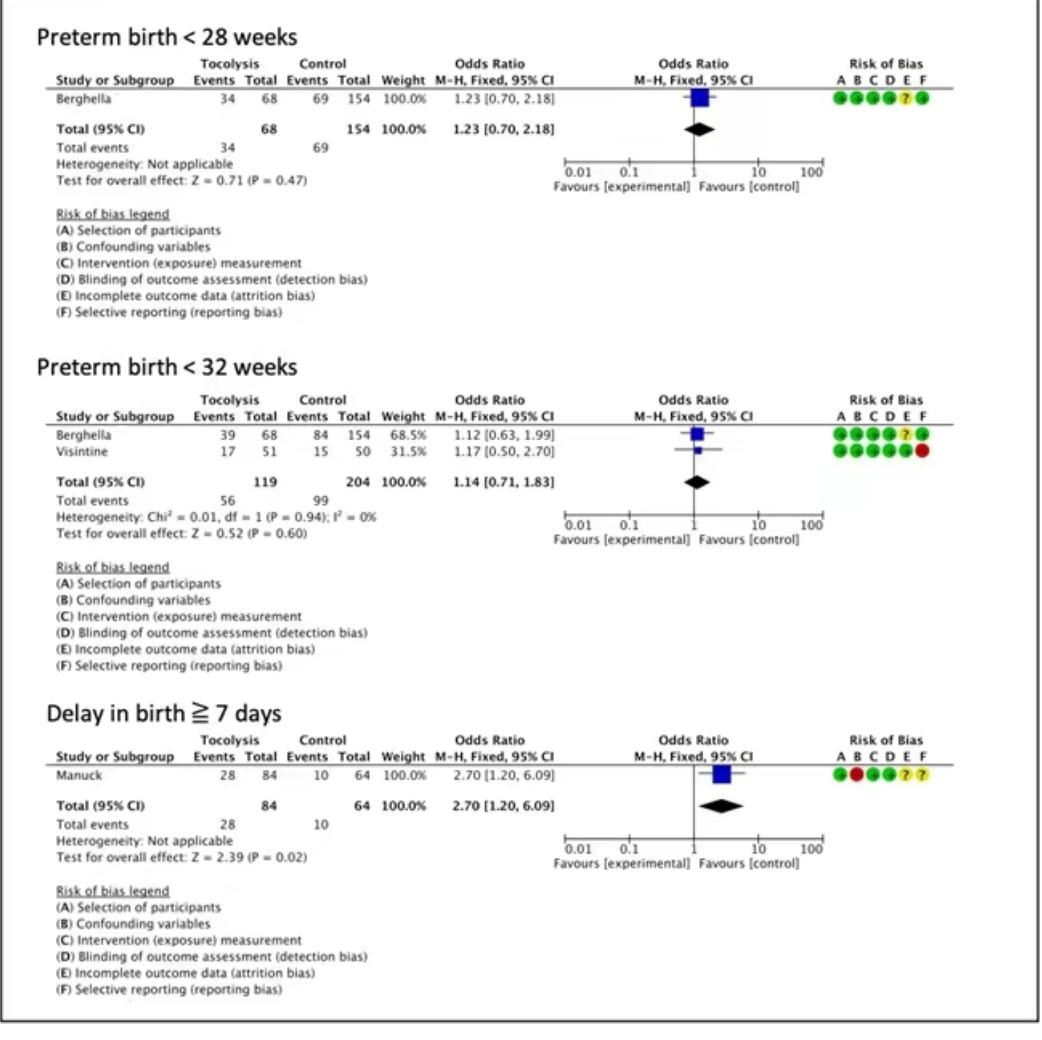
Figure 3. Tocolytics compared to placebo or no treatment—extreme prematurity (observational studies) [30,34,35].